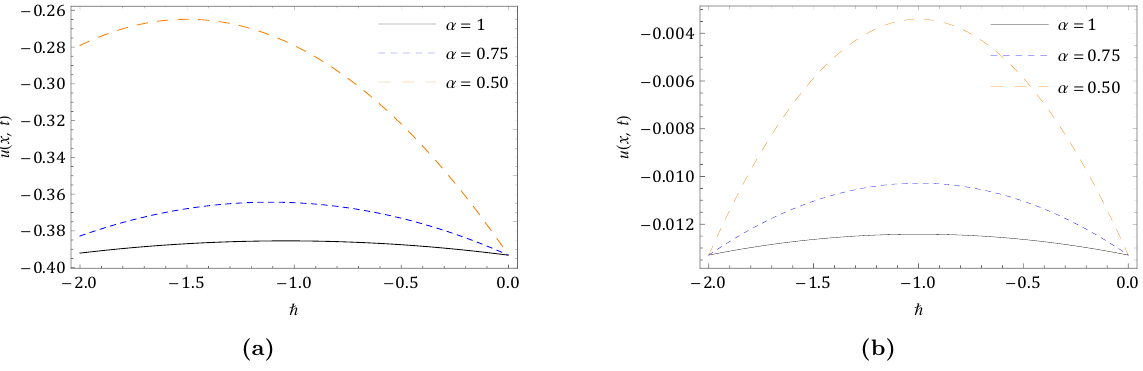
Figure 8. (cid:125) -curves for q -HATT solution with distinct α when n = 1 and t = 0 . 01 with ( a ) β = 2 at x = 1 and ( b ) β = 8 at x = 5. with different α for both cases (i.e., β = 2 and 8) and are respectively captured in Figure 8.